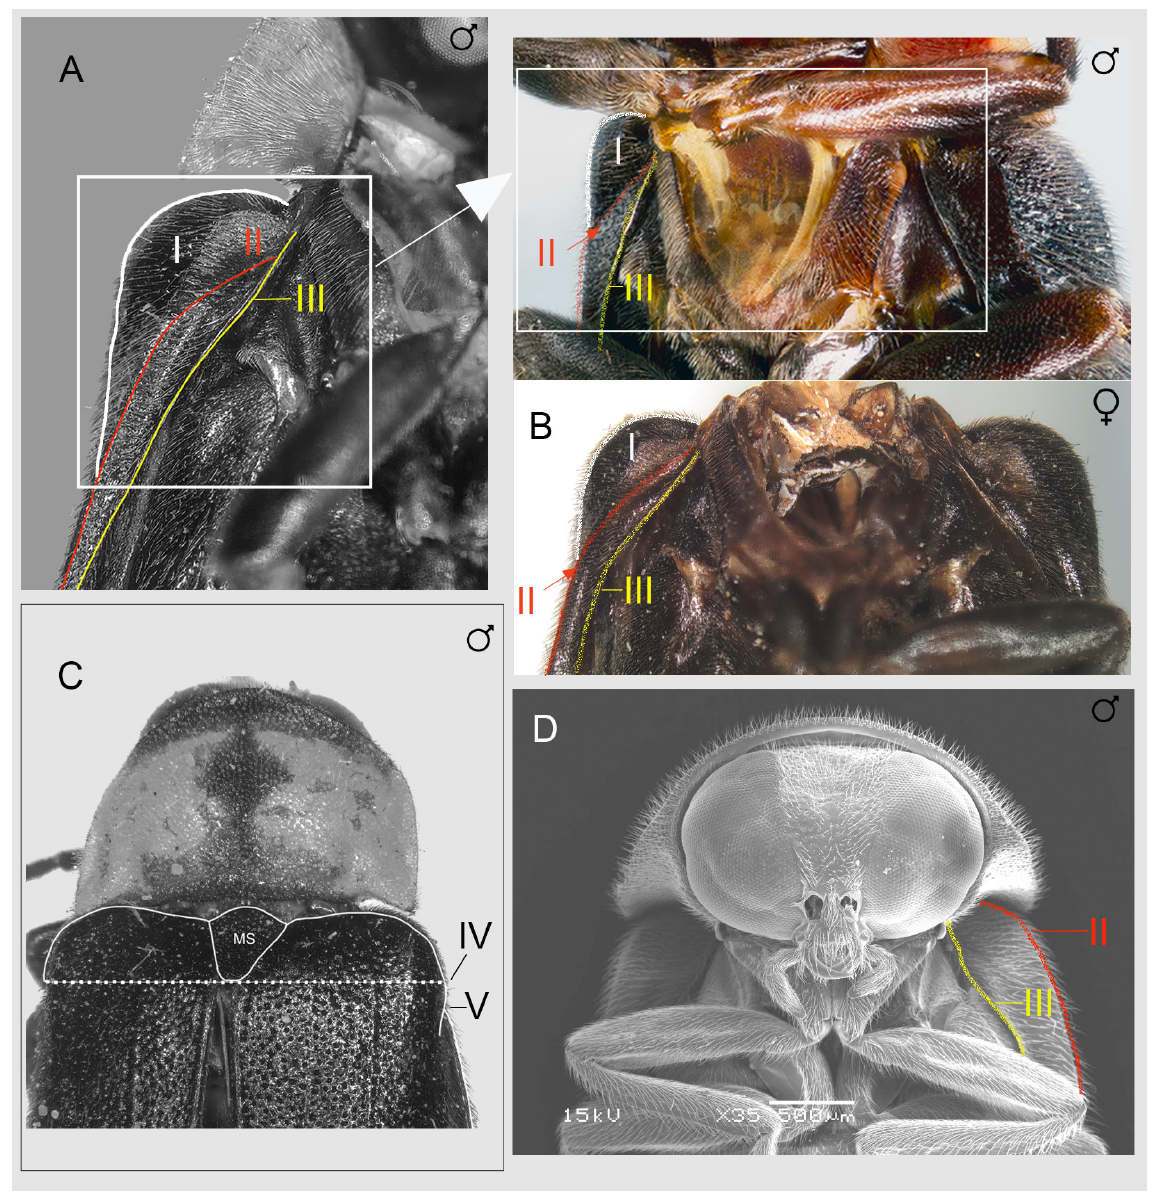
Fig. 3. Nature of epipleuron. A, C . Luciola cruciata Motschulsky, 1854, ♂ (Osugi, Japan; ANIC); inset A: Hayama, Japan; ZRC. B . Luciola cruciata ♀ (Doubaru, Japan; ANIC). D . Aquatica laterali s (Motschulsky, 1860) (Japan; XH Fu collection). A . Ventro-lateral thorax and elytron (inset: slightly oblique view of ventro-lateral thorax and elytron). B . Ventral anterior portion of mesothorax and elytral bases. C . Dorsal pronotum and elytral base of A. D . Ventral anterior body including head. Images by L. Ballantyne (A–C), W.F.A. Jusoh (inset A) and X.H. Fu (D, ex N. Ohba). Figure legends: I = humerus; II = outer edge of epipleuron; III = inner edge of epipleuron; IV = dotted line is posterior margin of MS; V = epipleuron first visible at side of elytron behind posterior margin of MS. Not to